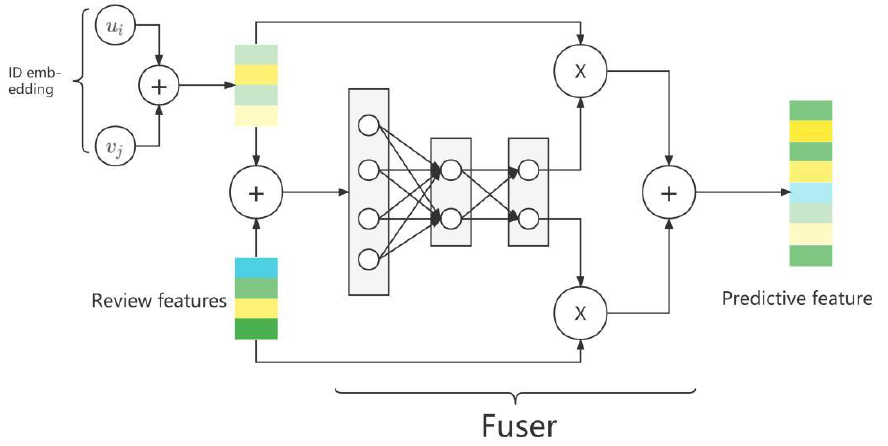
Figure 4. The structure of the fusion module.